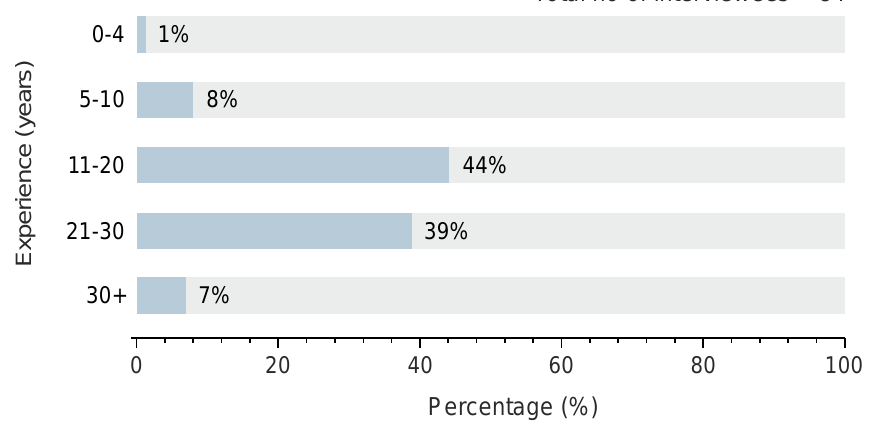
Figure 2. Years of participants’ experience in state-run public schools (percentages do not sum to 100 due to rounding).